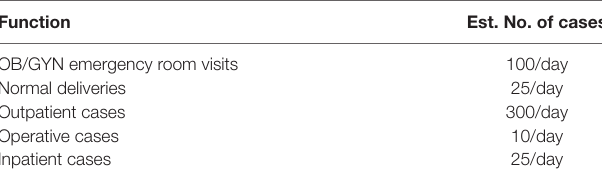
taBLe 1 | Brotherhood Medical Center medical services and estimated number of cases per day. Function est. no. of